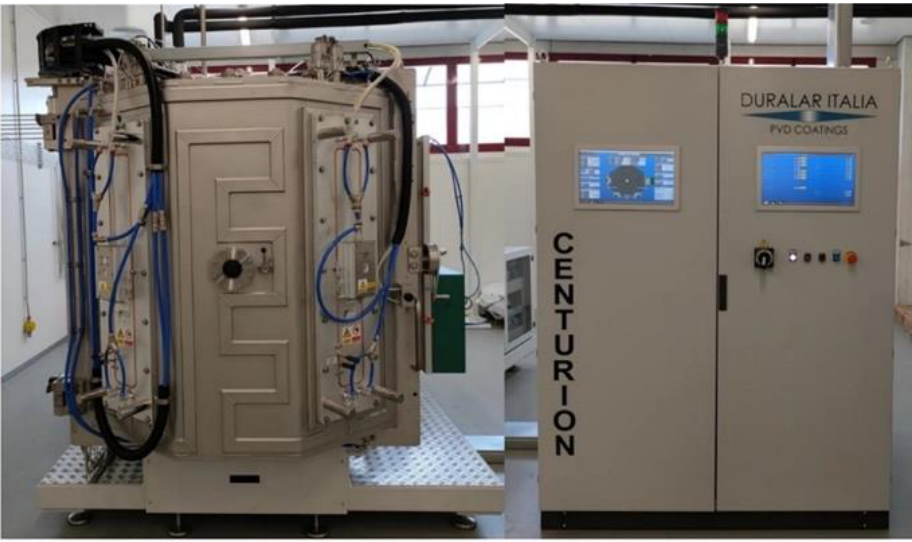
Figure 5. Photograph of Duralar Centurion system employed for PE-CVD deposition.